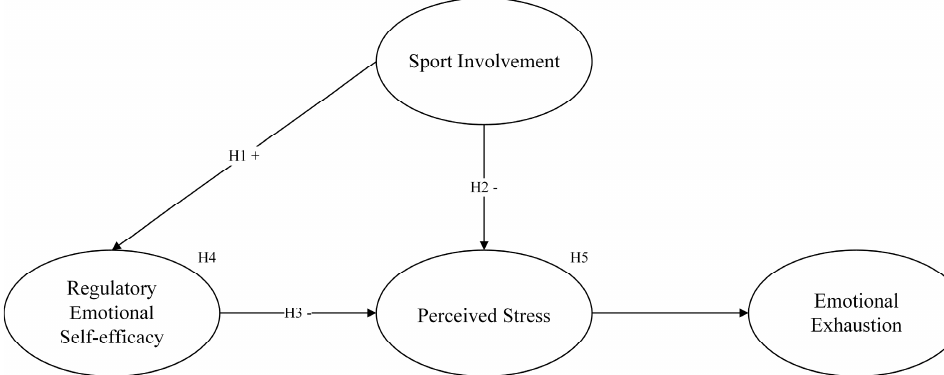
Figure 1. The hypothesized model.